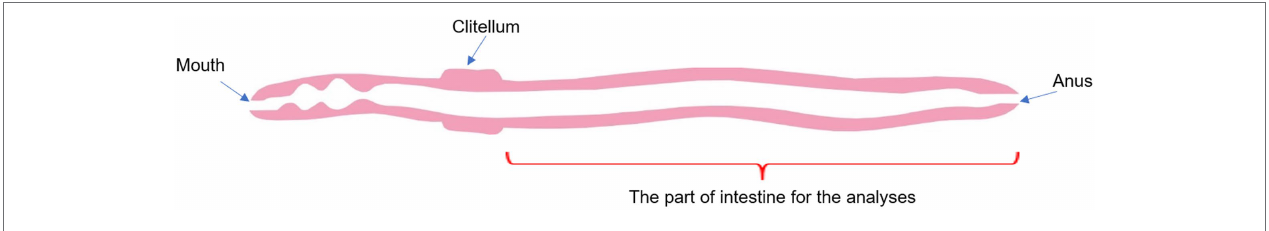
FIGURE 2 | Schematic diagram of the Lumbricus terrestris digestive